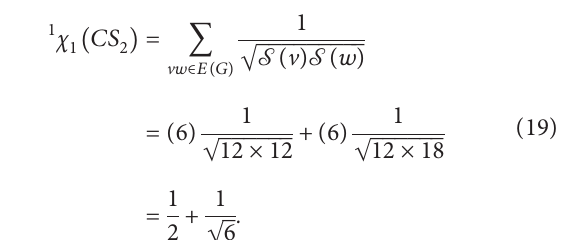
Table 5: Edge partition of CS